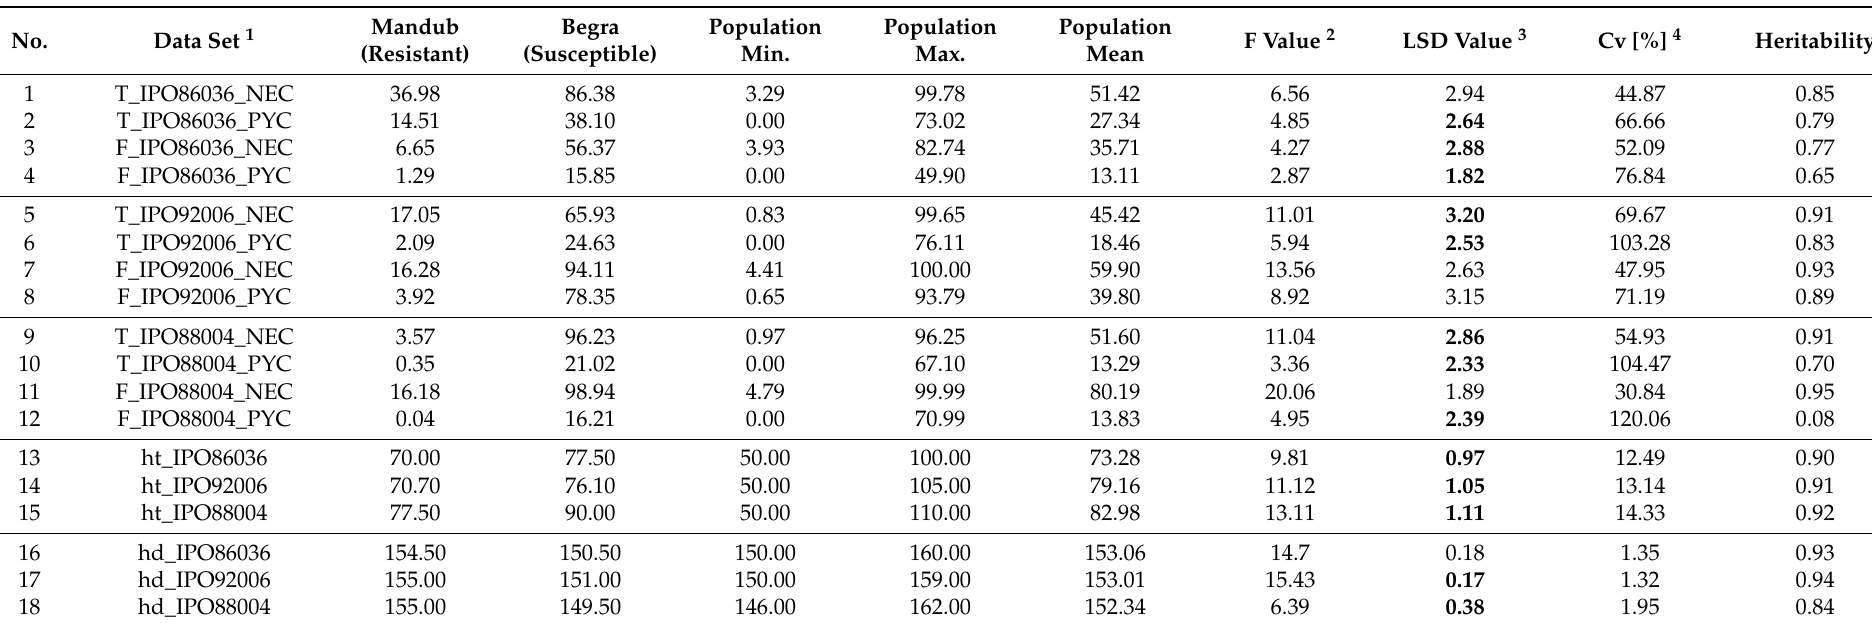
Table 2. Analysis of variance for disease severity and its heritabilities in the Mandub × Begra DH